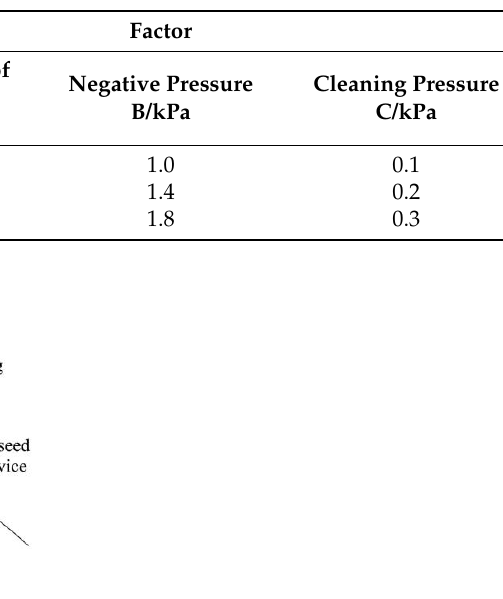
Figure 15. Schematic diagram of installation of seed cleaning mechanism.